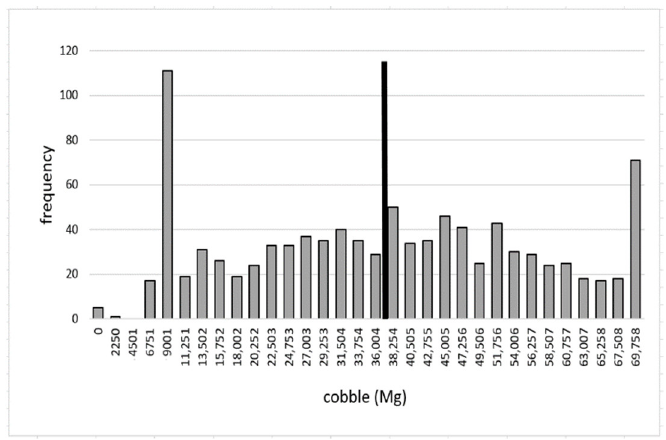
Figure A7. Histogram showing frequencies of achieving given quantity of sales of cobble for mine “D” with σ yprog .